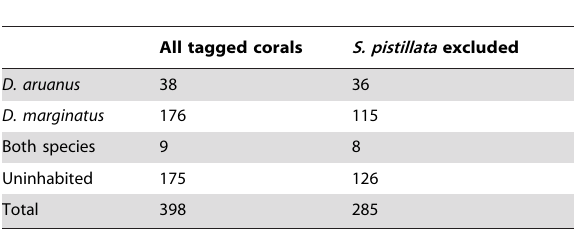
Table 1. Distribution of the tagged corals according to their host status (populated by D. aruanus , D. marginatus , both, or